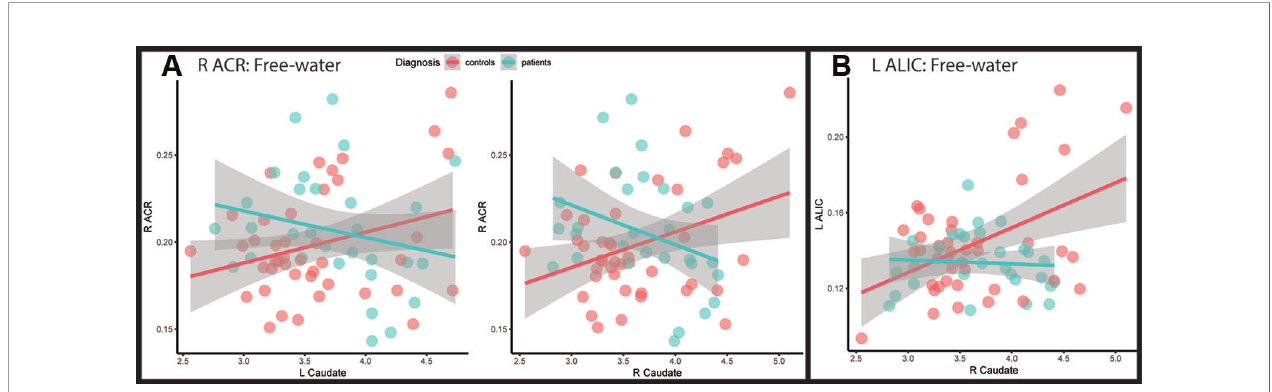
FIGURE 3 | Scatterplots of the (A) right anterior corona radiata and (B) left anterior limb of internal capsule with the subcortical structures that have signi fi cant interaction with diagnosis. Fitted lines were created using a generalized additive model. ACR, anterior corona radiata; ALIC, anterior limb of internal capsule; L, Left; R,